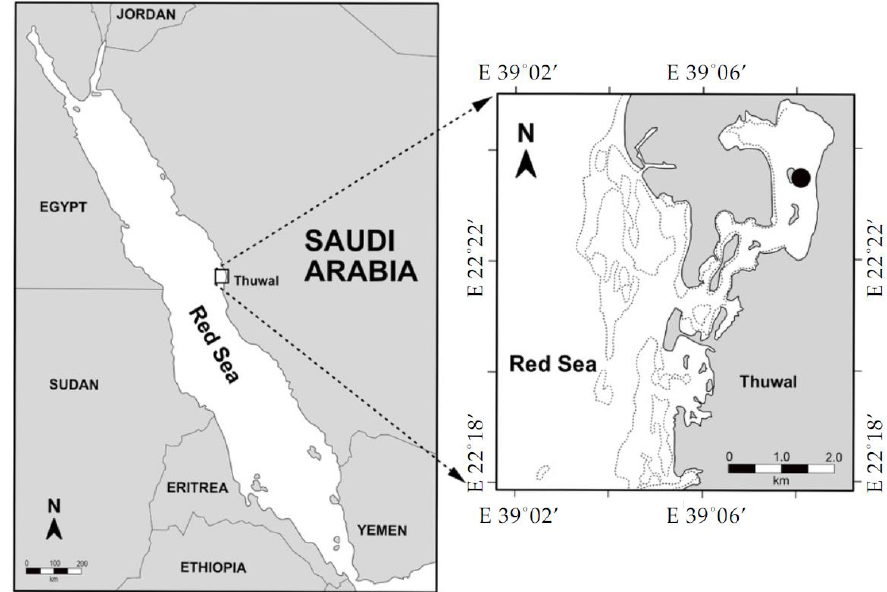
Figure 1. Location of the sampling station in the coastal central Red Sea (Saudi Arabia).